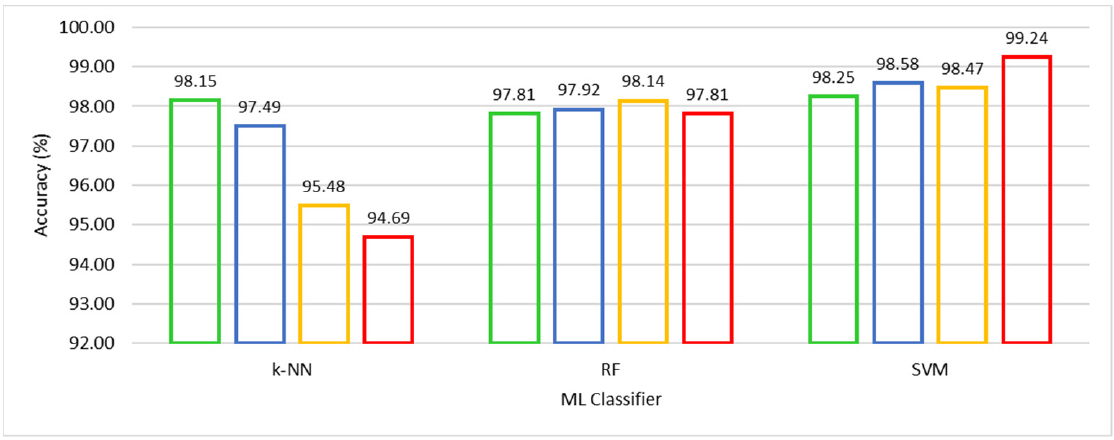
Figure 6. Quantitative performance comparison of k-NN with k ∈ { 1, 3, 5, 7 }, RF with N t ∈ { 500 , 550 , 600 , 650 } and SVM with O k ∈ { L , RBF , P 2 , P 3 } algorithms.